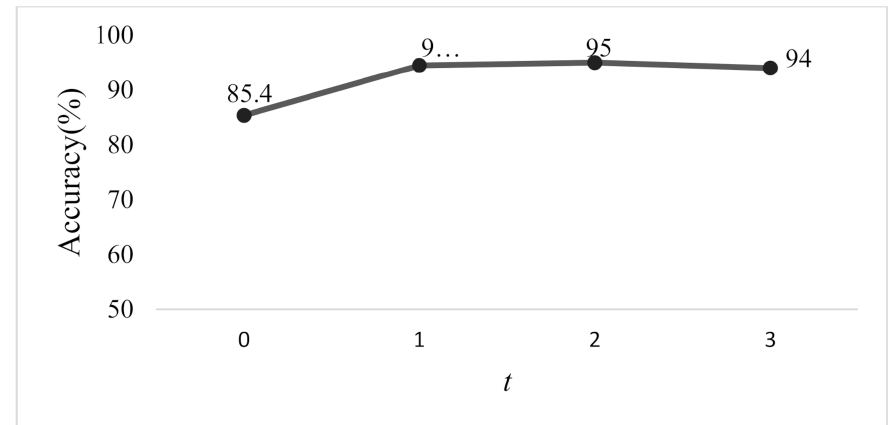
Figure 12. Recognition rates of different iterative layers.